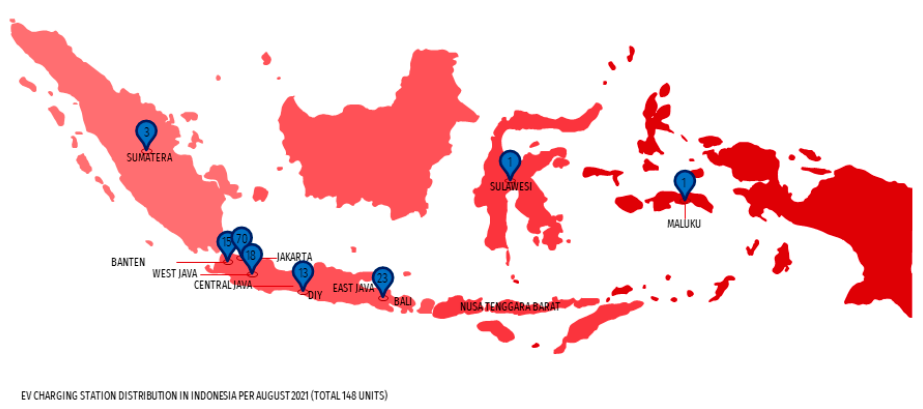
Figure 11. Level 3 charging stations distribution in Indonesia per August 2021.